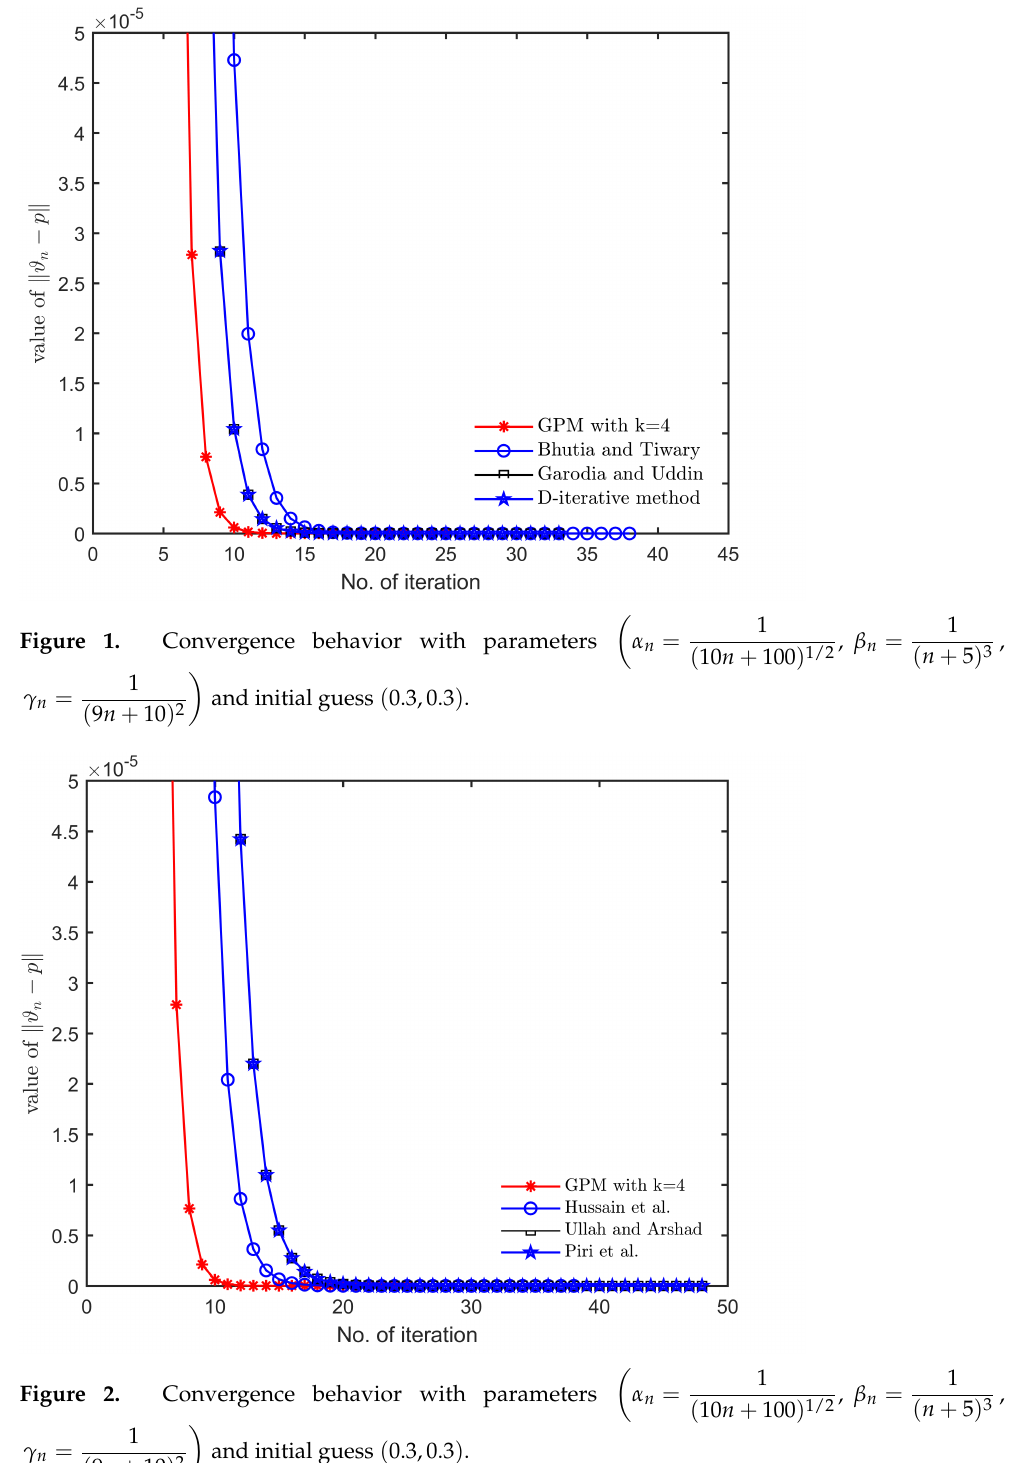
Figure 2. Convergence behavior with parameters (cid:19) 1 γ n = and initial guess ( 0.3,0.3 ) ( 9 n + 10 ) 2